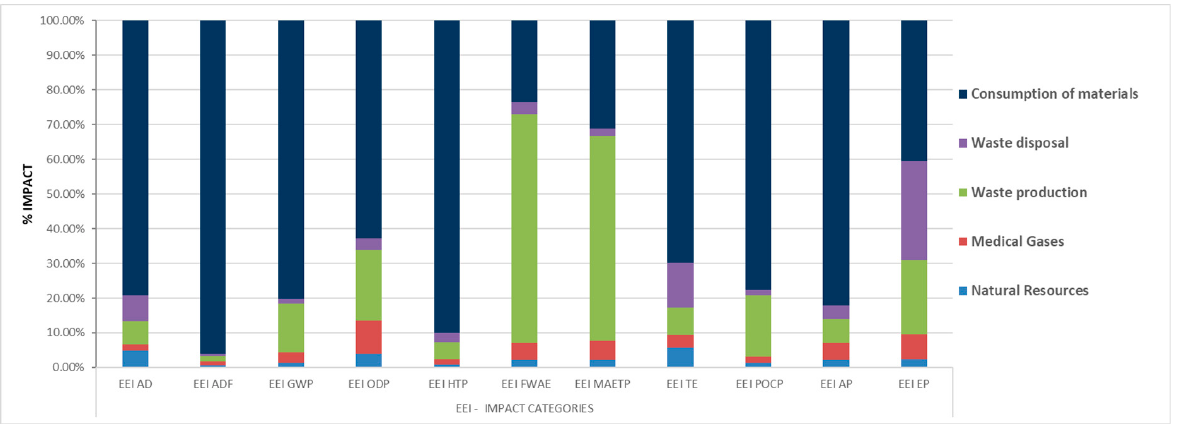
Figure 5. Distribution of the environmental impact of each environmental aspect in the environmental efficiency indices of the hospital activity.